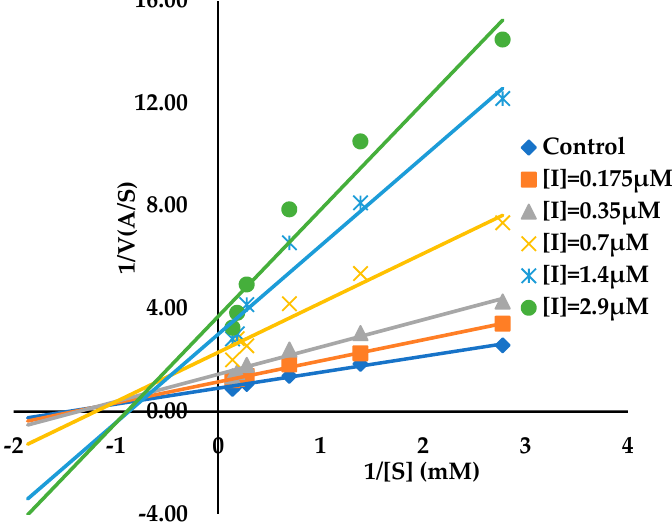
Figure 5. Double reciprocal plot for AGH in the presence of ECG at varying concentrations. The substrate concentrations were 0.36, 0.72, 1.44, 3.60, 5.40 and 7.20 mM, and the ECG concentrations were 0.175, 0.35, 0.7, 1.4, 2.9 µM. Control is reaction velocity in the absence of ECG.